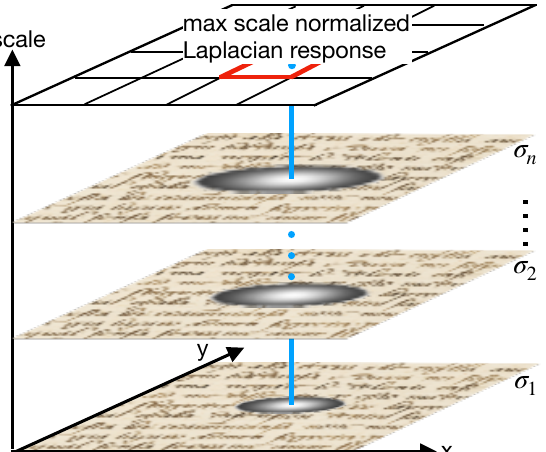
Figure 2. Scale-space representation with automatic scale selection is achieved by convolving the image with different scales ( σ 1 , σ 2 , · · · σ n ) and assigning the maximum scale-normalized convolution response to each pixel of the